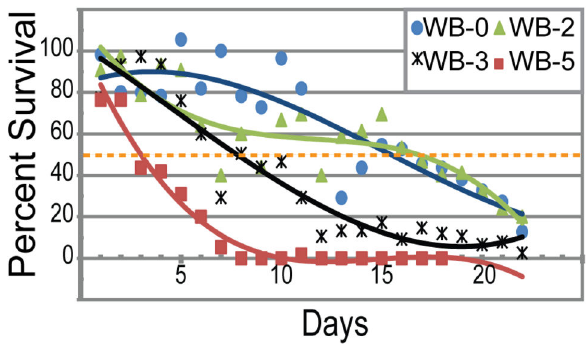
Figure 6. Adult lifespan in nickel-spiked sediment – survivorship curves. Recovery of Cel-fog-2 females from WB spiked nickel sediments, WB-0 (blue circles), WB-2 (green triangle), WB-3 (black asterisks), and WB-5 (red squares). Survivability decreases as nickel increases. Yellow-orange dotted line represents a 50% recovery. WB-0 and WB-2 show a 50% reduction around day 16. WB-3 shows a 50% reduction around day 7. WB-5 showed a 50% reduction around day 3. doi: